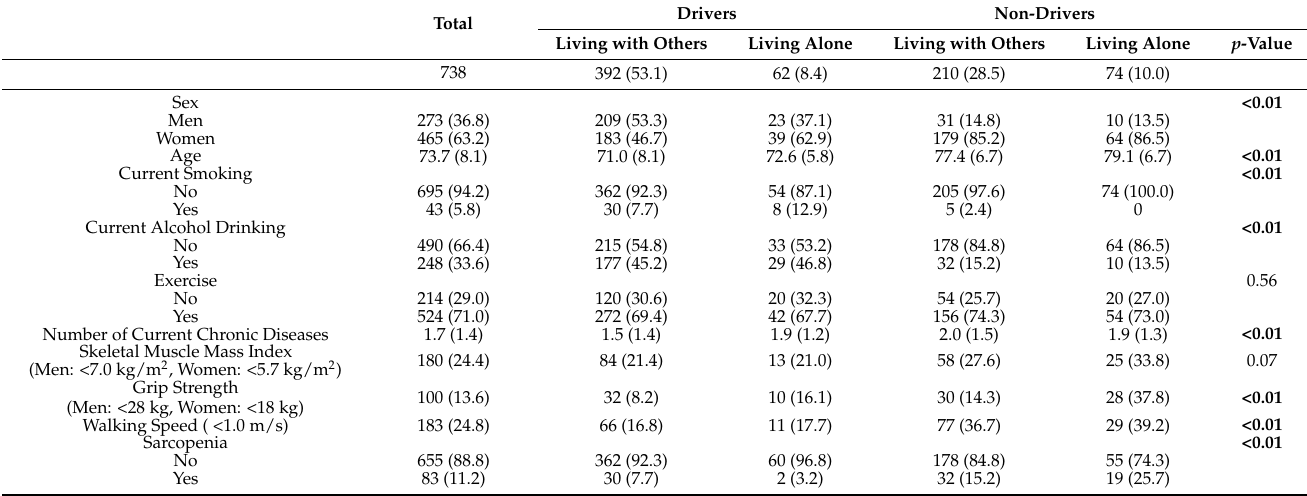
Table 1. Participants’ characteristics.